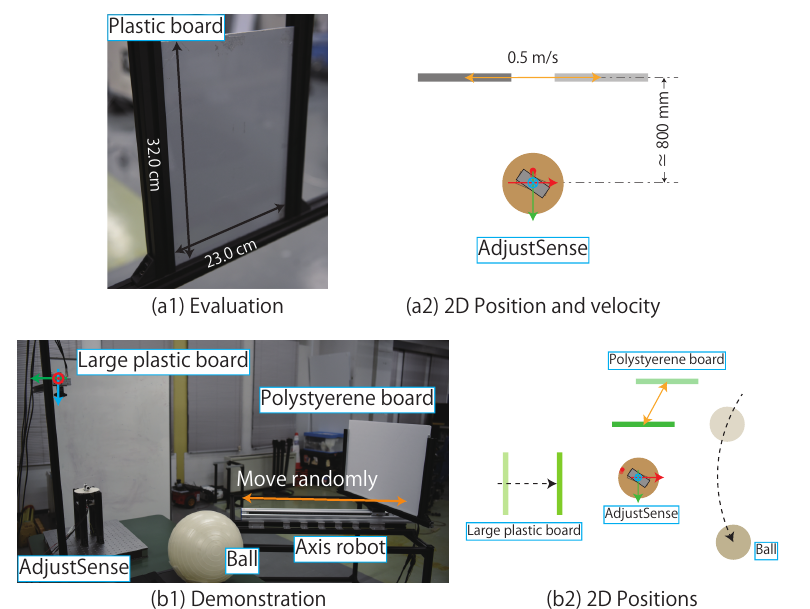
Figure 10. Measured objects for ( a1 ) evaluating spatio-temporal resolution, measurement range and measurement accuracy, ( b1 ) demonstrating 360 ◦ , and local sensing. ( a2 ) represents 2D position and velocity of measured object in ( a1 ) evaluation. ( b2 ) represents 2D positions of measured objects in ( b1 )